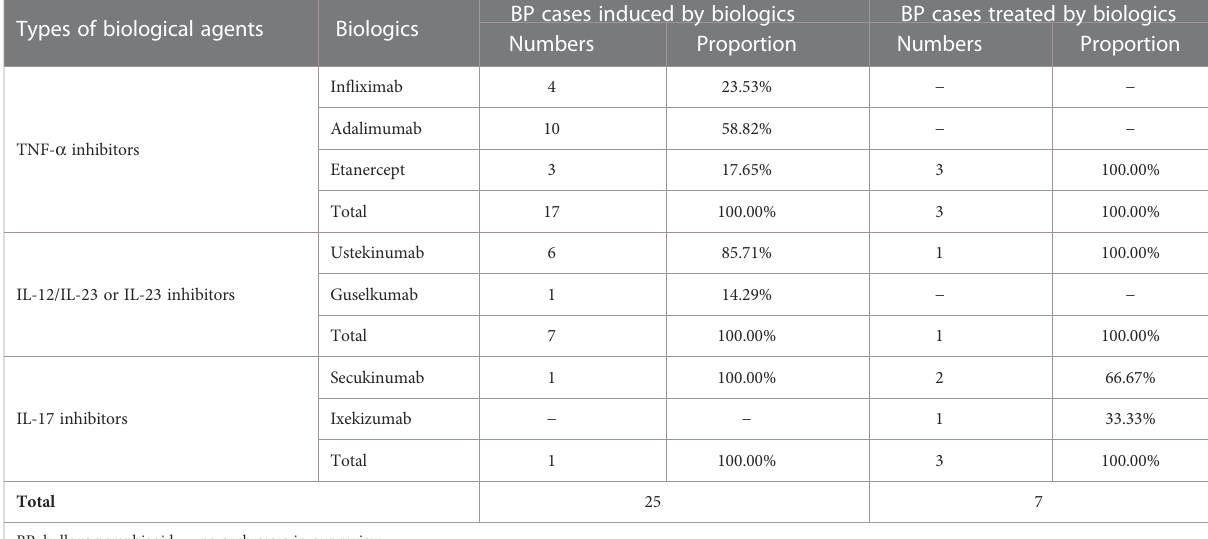
BP, bullous pemphigoid; − : no such cases in our